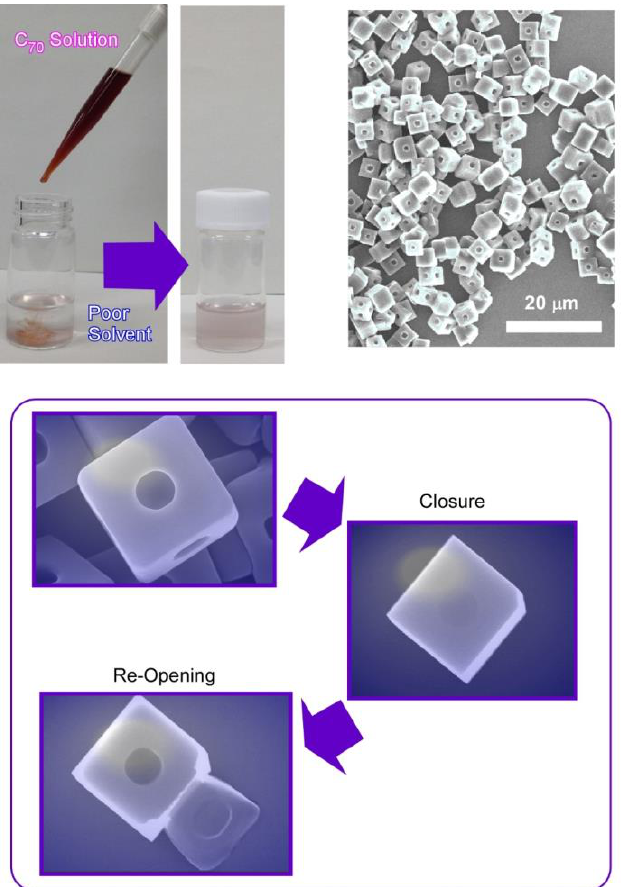
Figure 5. C 70 holes-in-cube structure with one regular micro-hole at the center of every face in the cubic structures and its shape-shifts for closure and re-opening of the